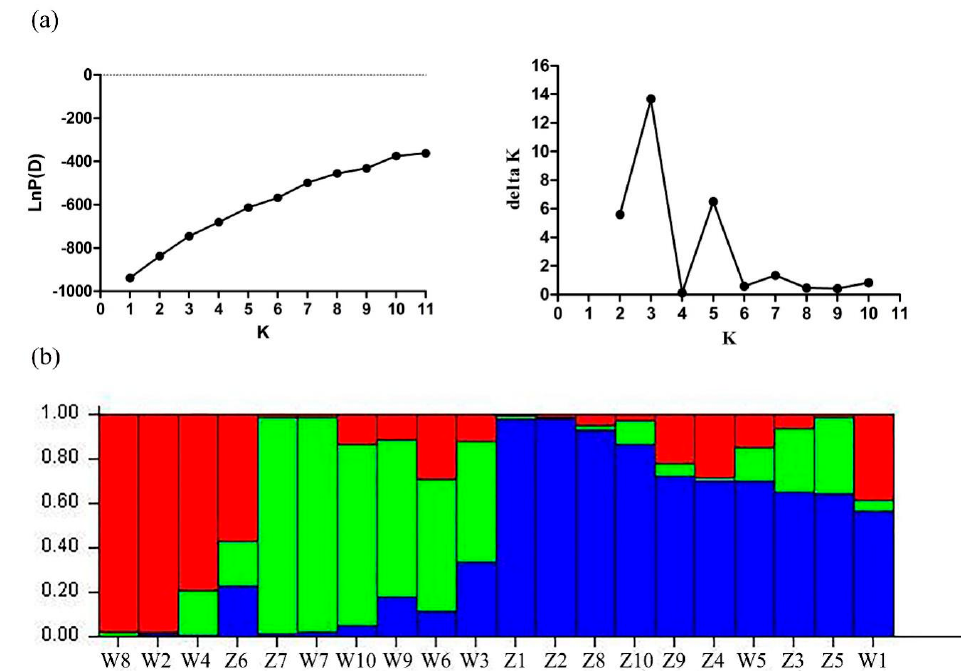
Figure 8. Population structure of 20 E. sibiricus accessions inferred from the STRUCTURE program with 15 candidate gene-based EST-SSR markers data set. ( a ) Mean Ln P(D) over 20 runs for each K value, and maximum delta K ( ∆ K) values were used to determine the uppermost level of structure for K ranging from 1 to 11, where K is three and three clusters; ( b ) three major groups of 20 E. sibiricus genotypes. The vertical coordinate of each group indicates the membership coefficients for each genotype. Different codes and corresponding vertical lines represent individual genotype and different colors represent stock.